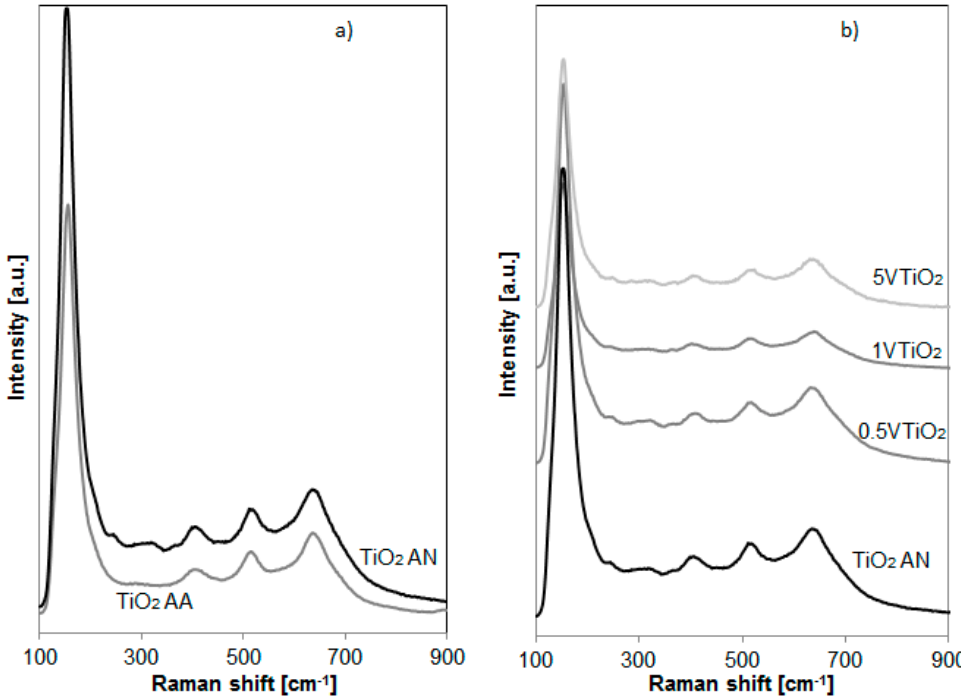
Figure 1. Raman spectra of ( a ) TiO 2 AA and TiO 2 AN; ( b ) TiO 2 AN, 0.5VTiO 2 , 1VTiO 2 and 5VTiO 2.